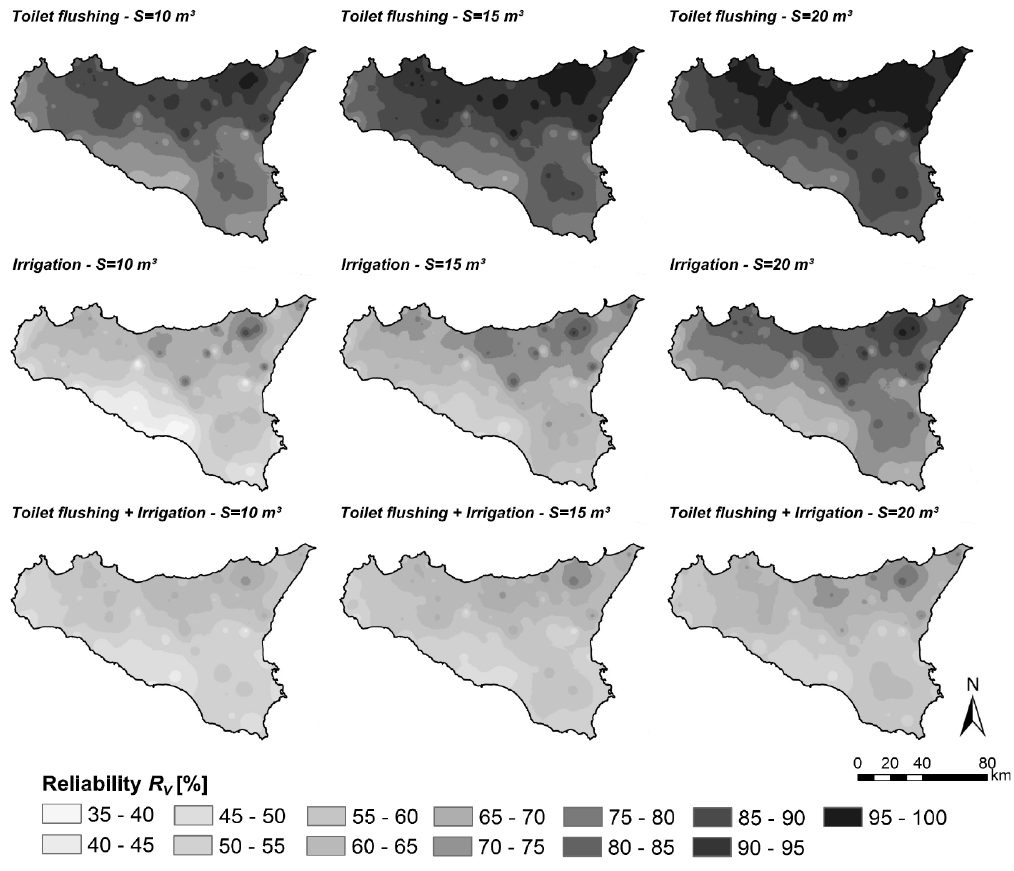
Figure 5. Spatial distribution of mean annual reliability R V (%) for different rainwater uses and for S equal to 10, 15 and 20 m 3 .